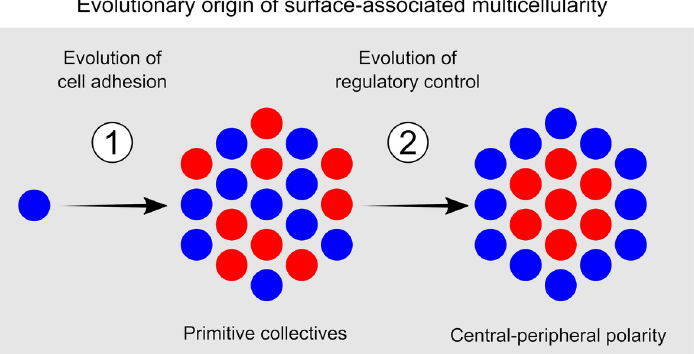
Fig 4. Proposed evolutionary origin of surface-associated multicellularity. First, cell adhesion evolves, leading to cryptic cell collectives on a surface. Second, regulation evolves which leads to central-peripheral polarity, which brings about a characteristic collective